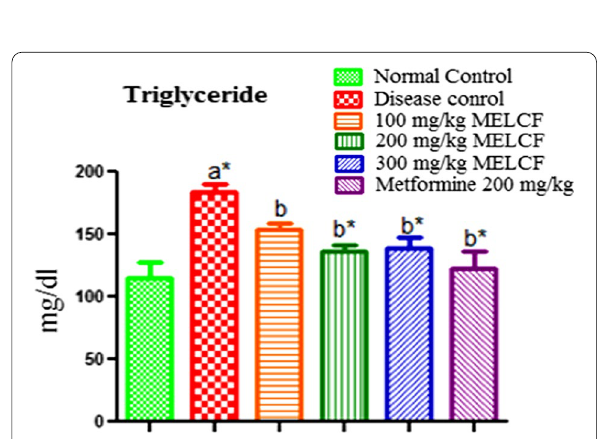
dependant manner respectively which was equivalent to standard treatment group metformin 200 mg/kg body weight.